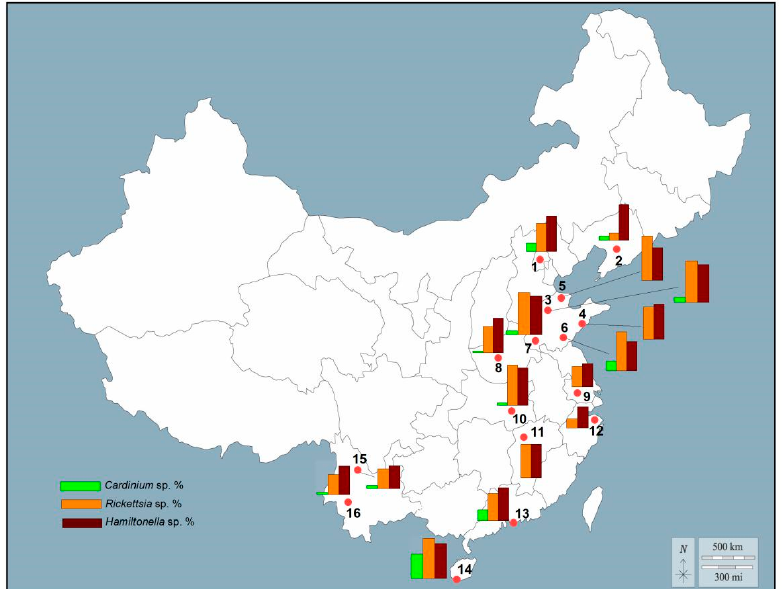
Figure 4. Infection frequency of three facultative endosymbionts in Bemisia tabaci MED populations across China. Green, yellow, and brown bars represent the infection frequencies of Cardinium sp., Rickettsia sp., and Hamiltonella sp., respectively. The red circles represent the sampling locations. Numbers on the map correspond to locality numbers in Table S3 in the Supplemental Materials.